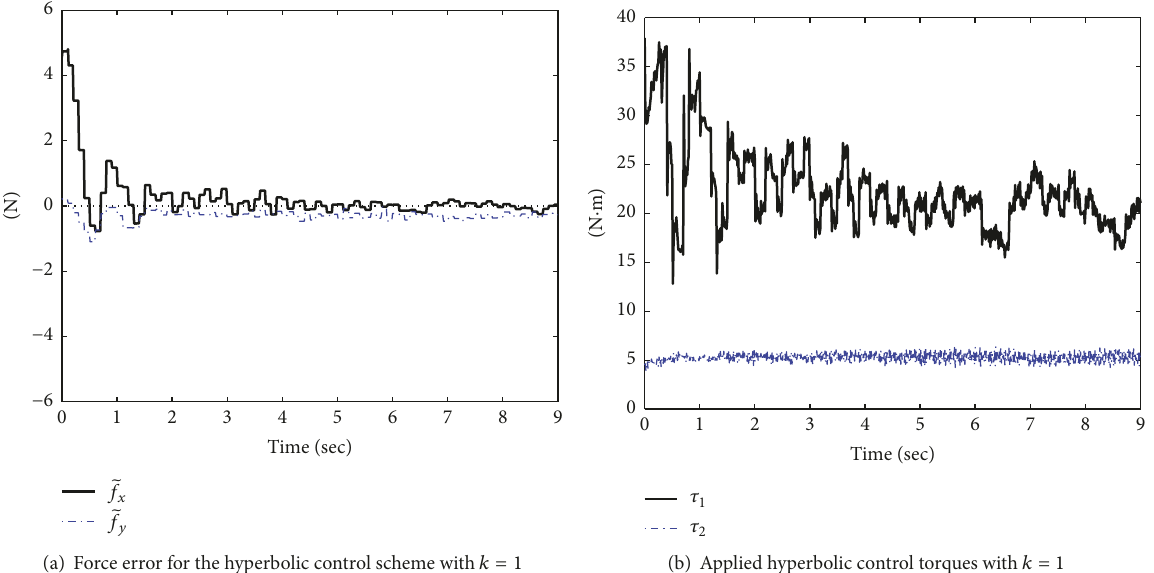
Figure 5: Experimental results of the hyperbolic control 𝜏 1 = J ( q ) 𝑇 f 𝜒1 for 𝑘 = 1 .